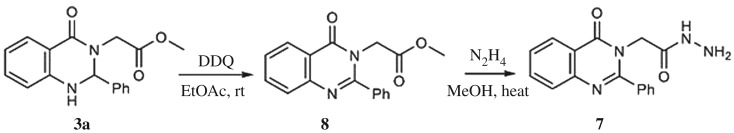
Synthetic route to compound 7.